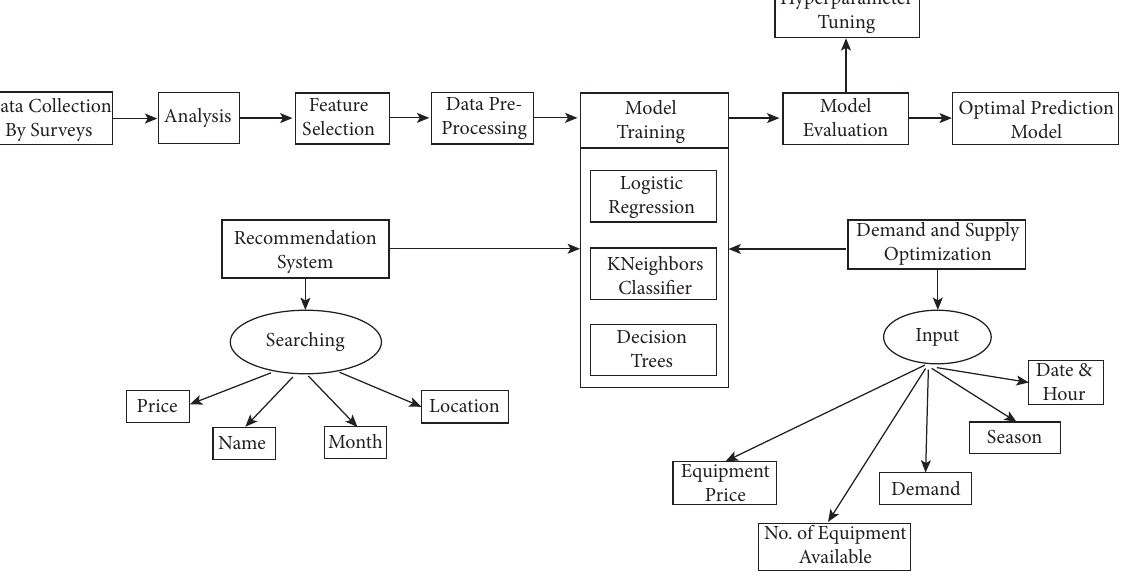
Figure 6: Accuracy